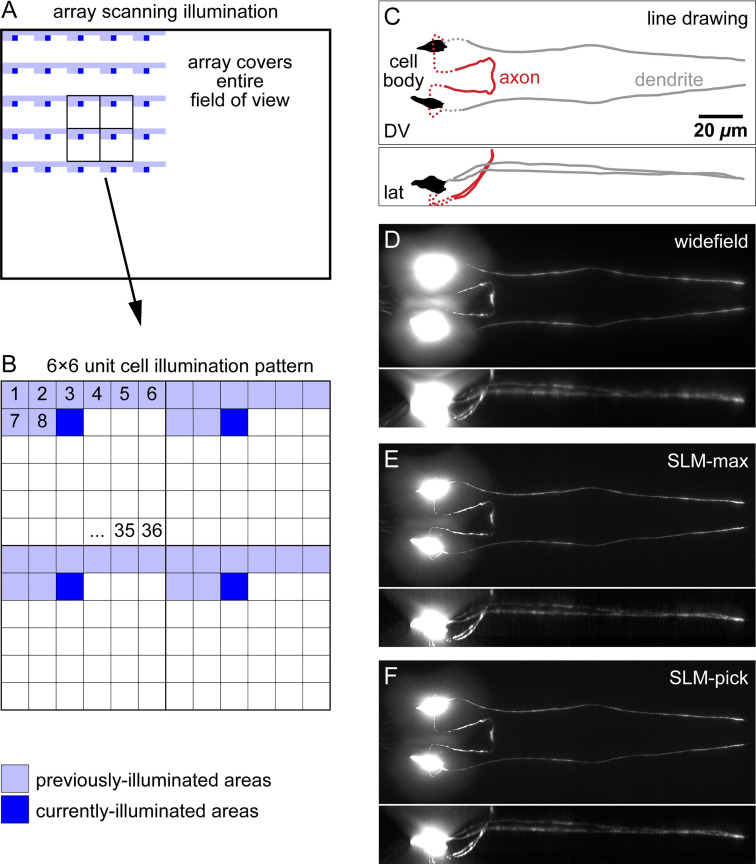
Illumination strategies and postprocessing.(A) Dot array transmitted by SLM illuminates sample. Array is raster scanned across FOV. (B) Expansion of inset in (A). Raster scanning moves single-element illumination through 36 locations of 6 × 6-unit cell. Sub-image of entire FOV is acquired for each of 36 illumination patterns. (C) Line drawing of ASJ neuron imaged. Dorsal-ventral view in xy direction (top), lateral view in xz direction (bottom). (D-F) Fluorescence images, obtained by maximum projections of 3D image. (D) Conventional widefield image. (E) SLM-max image. Pixel value in 3D image is maximum pixel value of 36 subimages. (F) SLM-pick image. Pixel value is in 3D image is pixel value when corresponding sample location is illuminated. Note significantly improved optical sectioning in the max and pick strategies, mostly visibly above and below the cell bodies. Fluorescent image normalization saturates pixels near cell body to visualize dim neuronal fibers.